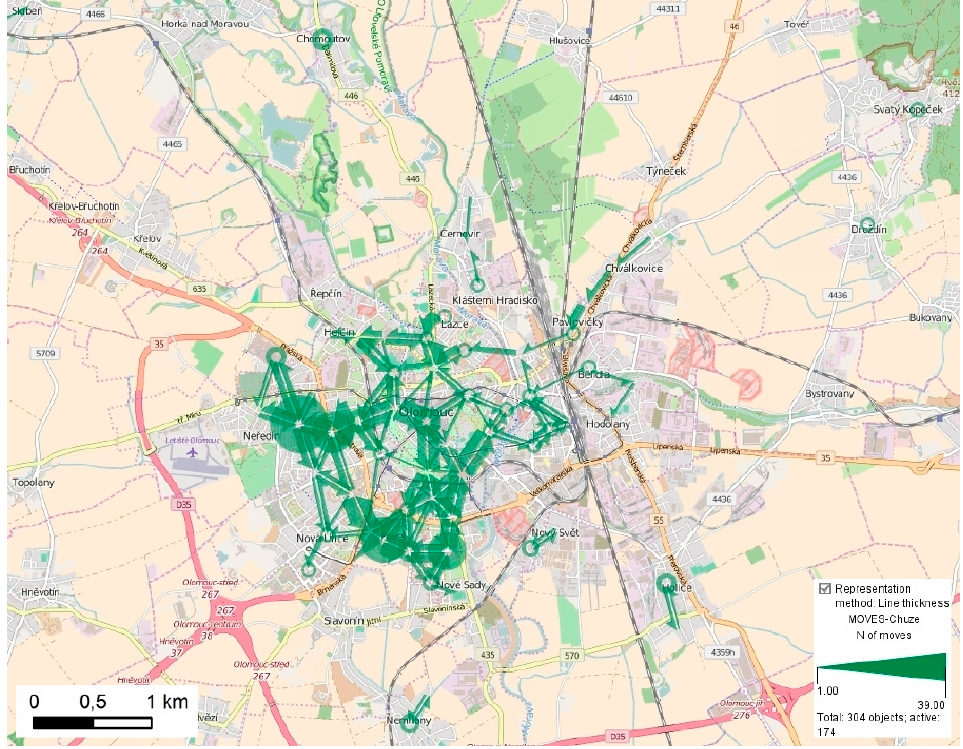
Figure 15. Dominant directions of movement in Olomouc according to walking.